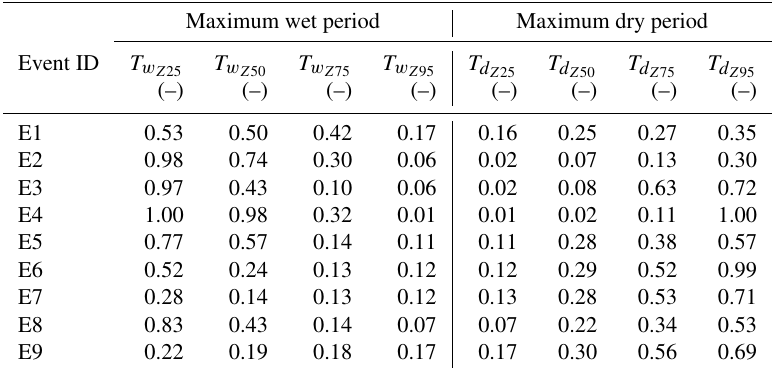
Table 6. Maximum wetness periods above the threshold, calculated for each pixel, averaged over the total catchment, and then divided by the total duration.